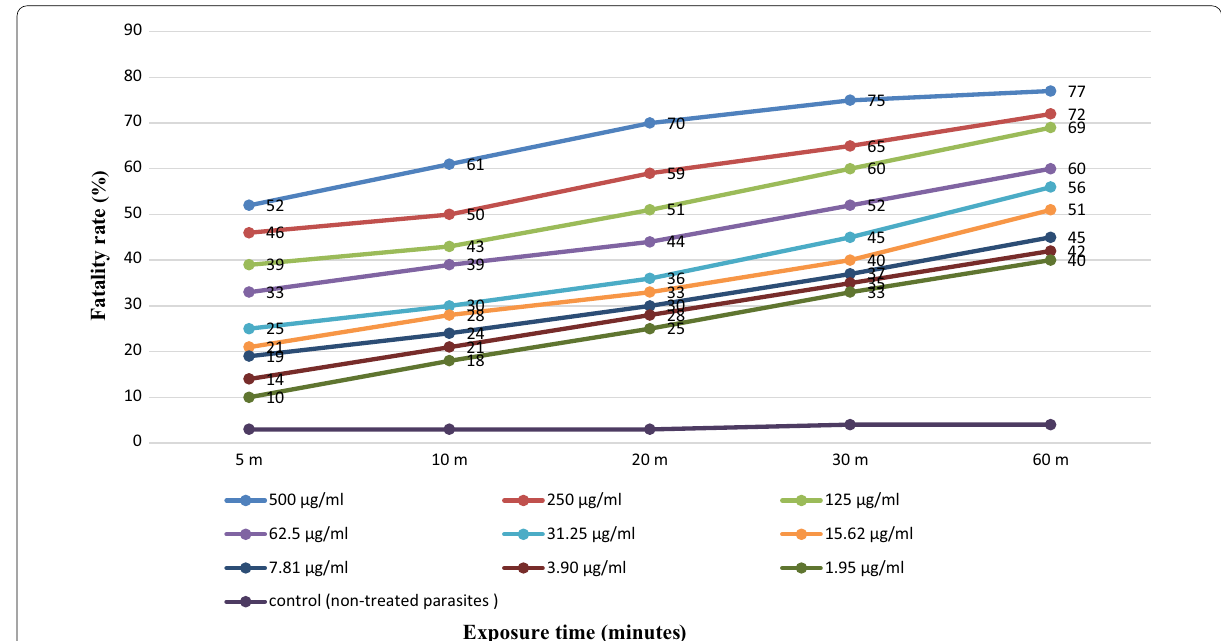
Fig. 4 Scolicidal effects of ethanolic extract of S. marianum after exposure at different concentrations for 60 min. Each point represents the mean percentage of fatality rate